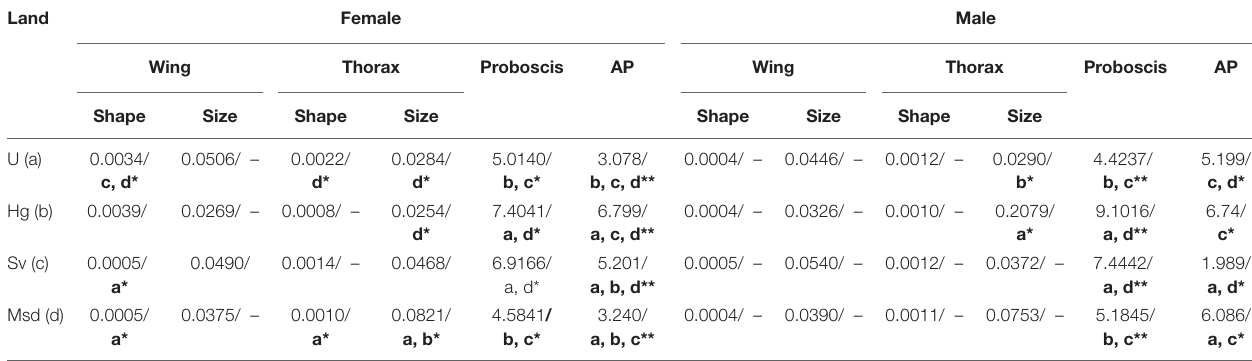
Procrustes variance for landscape classes (Upper)/statistical significance represent by letters (lower, p < 0.05*, 0.001**).